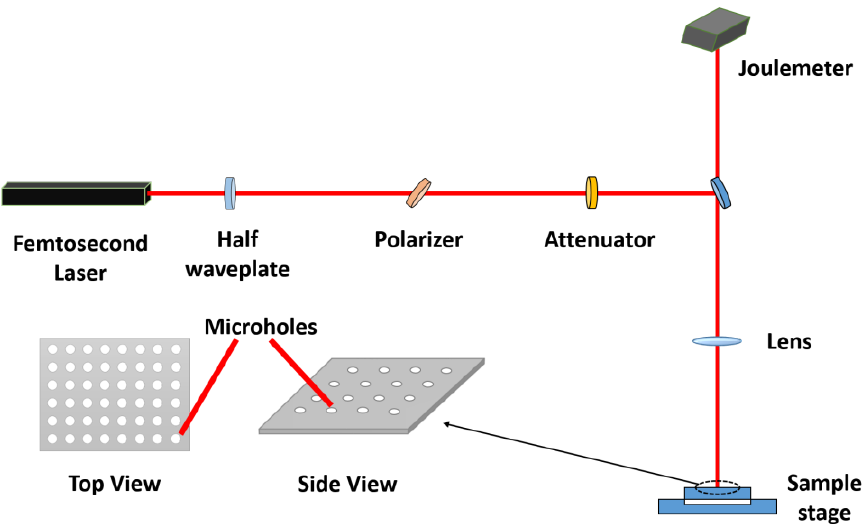
Figure 2. Typical setup used for femtosecond laser surface structuring and microfabrication.